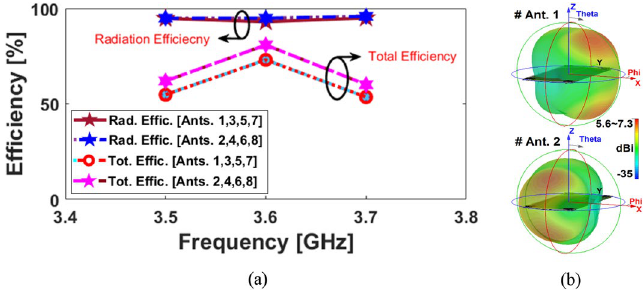
Figure 9. ( a ) Efficiencies of the MIMO elements, and ( b ) radiation patterns of Ant. 1 & Ant.